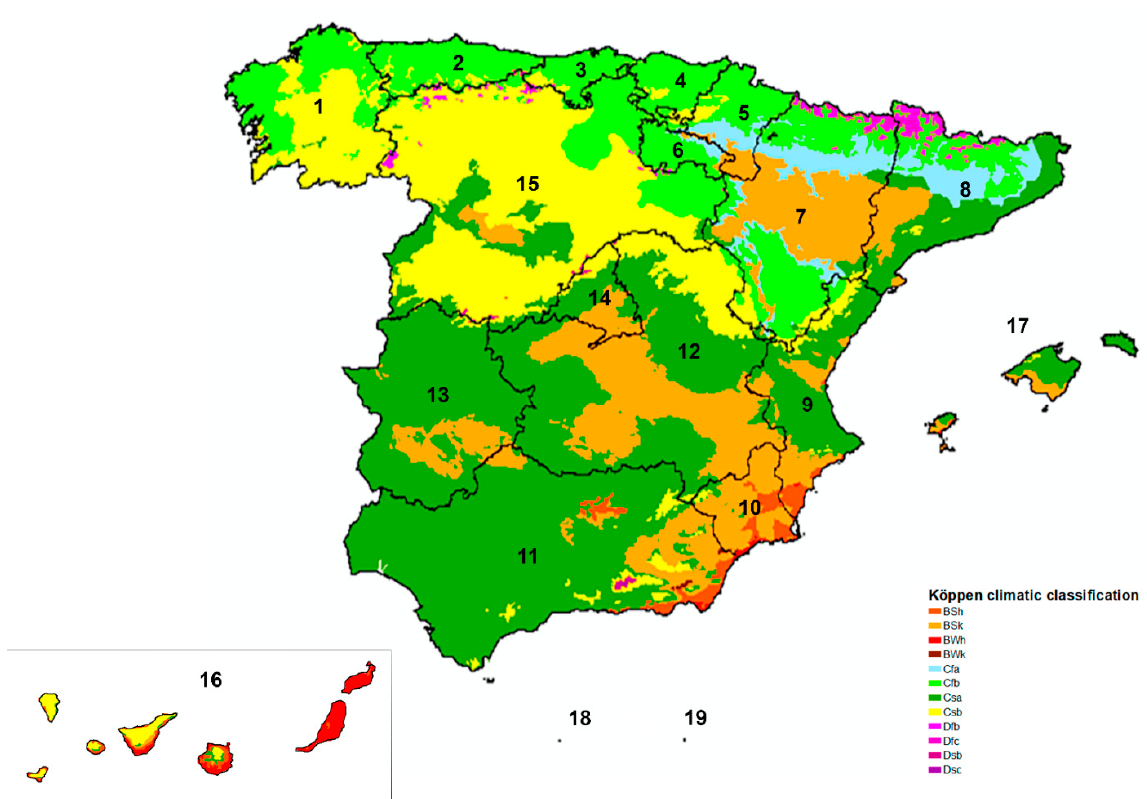
Figure 1. Map with the main climates present in Spain (Köppen Climate Classification System). The numbers correspond to the autonomous communities and autonomous cities, as described in